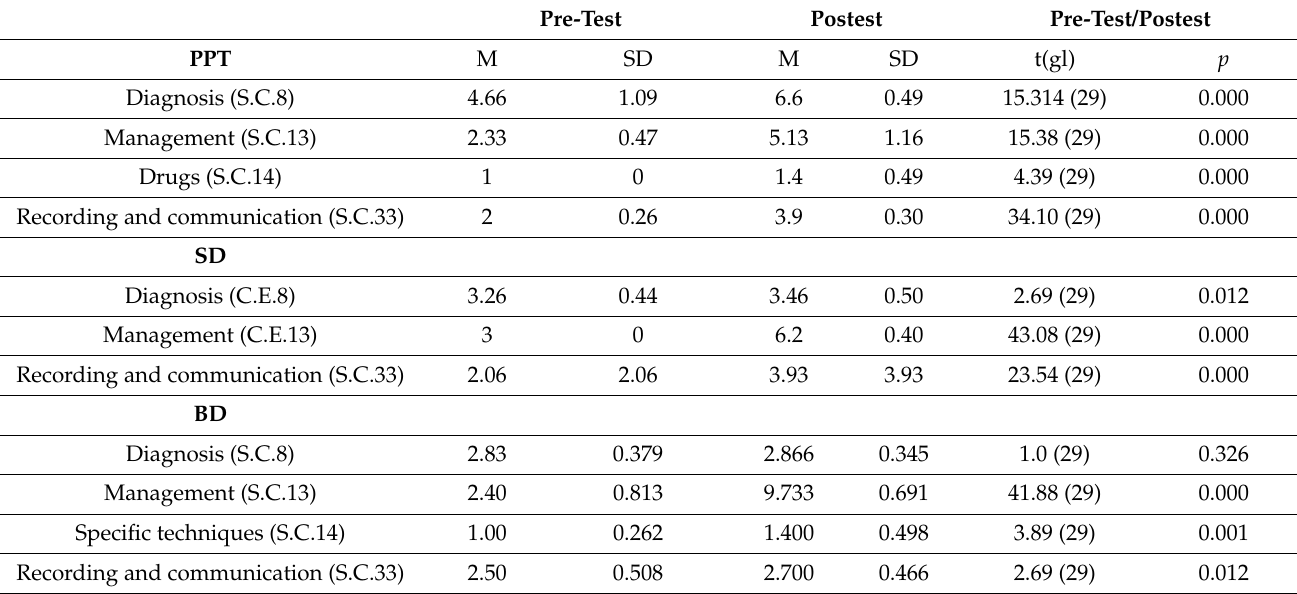
Table 7. Differences in means (M) between the pre-test and post-test results obtained in the